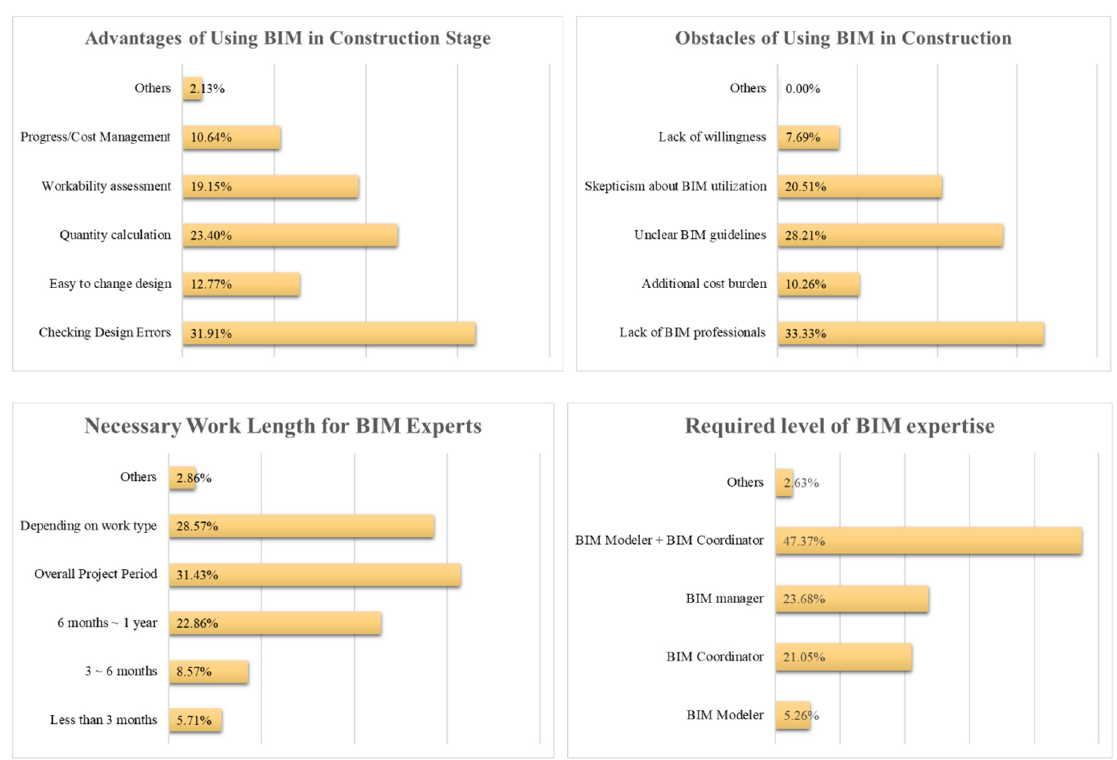
Figure 5. Preferences on BIM during Construction Stage.